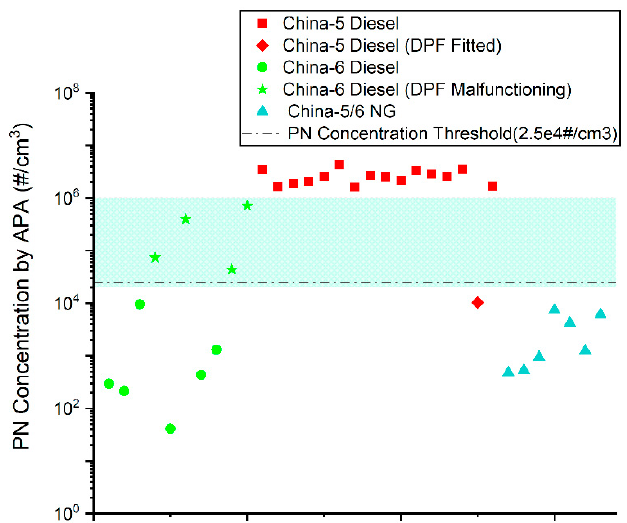
Figure 5. Result of idle PN concentration measurement.